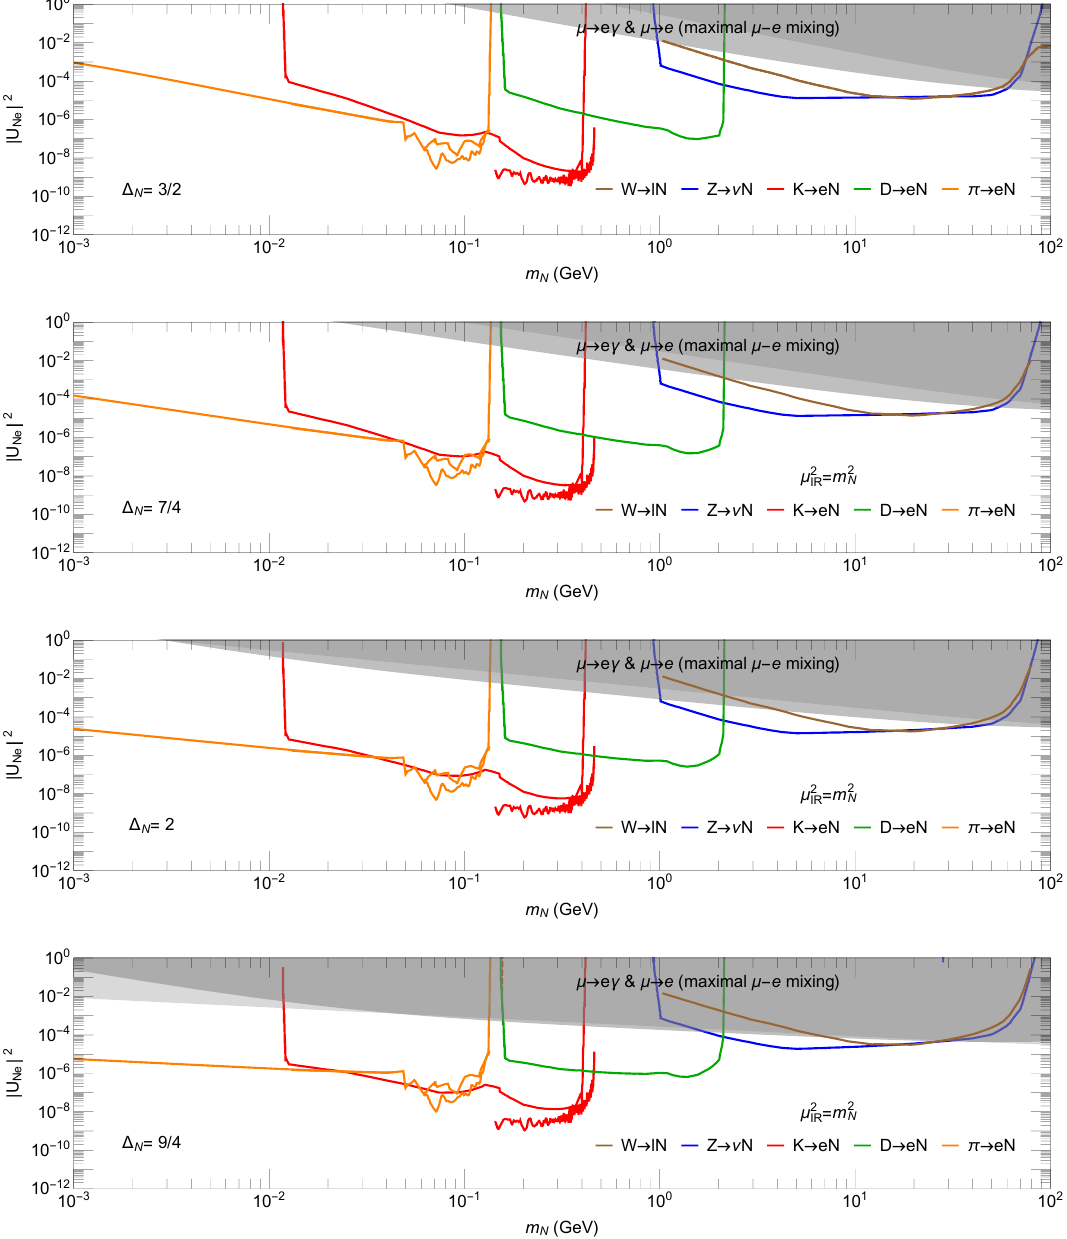
Figure 7 . The existing limits on the IR mixing angle as a function of composite neutrino mass ( m Λ , the compositeness scale) for final states involving electrons. These bounds are a rein- N ∼ terpretation of constraints on HNLs, as discussed in the text. The lower and upper shaded gray regions correspond to the flavor dependent constraints from the µ → e conversion and µ → eγ measurements in the maximal electron-muon flavor mixing scenario, which is discussed in the next